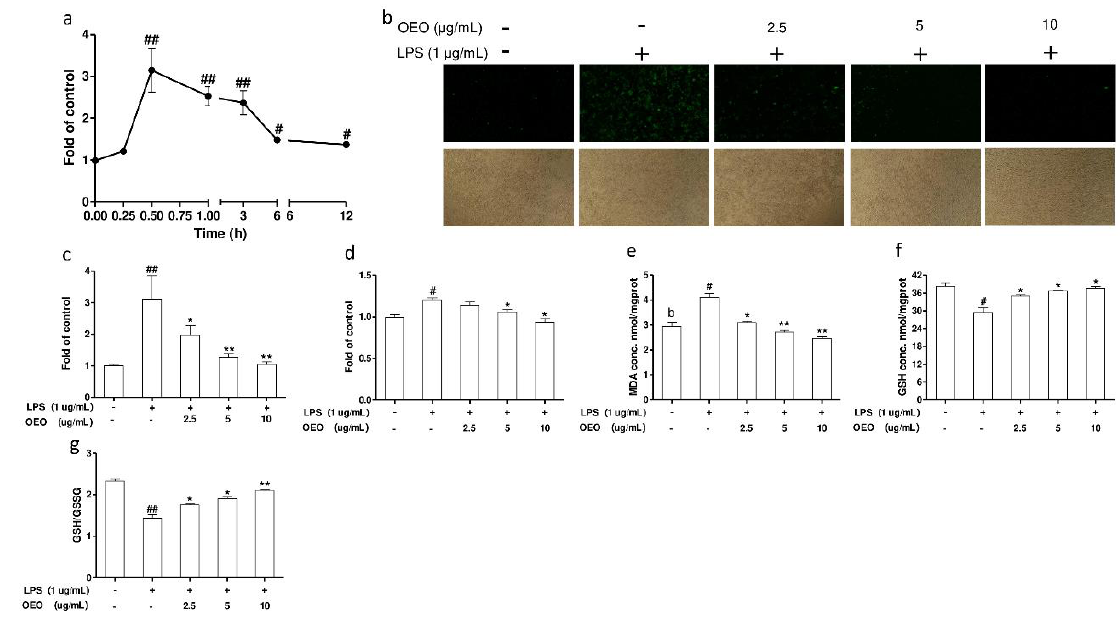
Figure 3. OEO inhibits LPS-induced oxidative stress in RAW264.7 cells. ( a ) The RAW264.7 cells were incubated with 1 µ g/mL of LPS. The fluorescence intensity of the dichlorofluorescein (DCF)-stained cells was quantified using a flow cytometer. ( b ) Cells were pretreated with OEO for 12 h, then incubated with 1 µ g/mL of LPS for 30 min. The intracellular reactive oxygen species (ROS) levels were indicated by DCF fluorescence and detected by fluorescence microscopy. ( c ) Cells were pretreated with OEO for 12 h, then incubated with 1 µ g/mL LPS for 30 min. The fluorescence intensity of DCF-stained cells was quantified using a multidetection reader. ( d ) Cells were pretreated with OEO (2.5–10 µ g/mL) for 12 h, then incubated with 1 µ g/mL of LPS for 30 min. The levels of ROS in the culture supernatant were measured by chemiluminescence. ( e – g ) Cells were pretreated with OEO for 12 h, then incubated with 1 µ g/mL of LPS for 12 h. The intracellular malondialdehyde (MDA), the glutathione (GSH) levels and GSH: oxidized glutathione (GSSG) ration were measured. Values represent means ± SEM, n = 3. # p < 0.05 and ## p < 0.01 compared to the control group, while * p < 0.05 and ** p < 0.01 compared to the LPS-treated